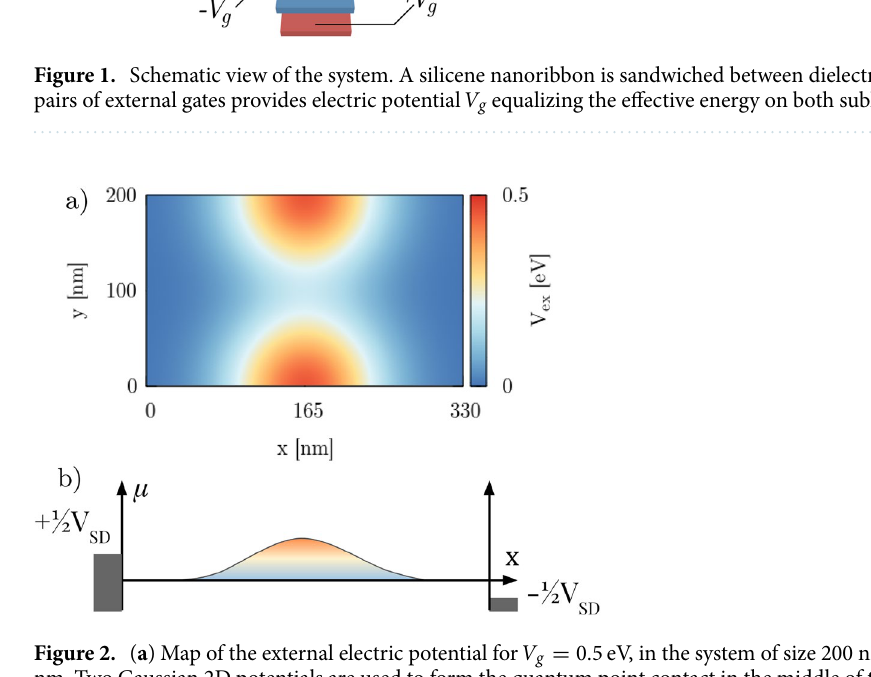
Figure 2. ( a ) Map of the external electric potential for V g nm. Two Gaussian 2D potentials are used to form the quantum point contact in the middle of the silicene nanoribbon. ( b ) Profile of the QPC. The occupied states below chemical potential ( sides by rectangles with the assumption of a symmetric drop along the